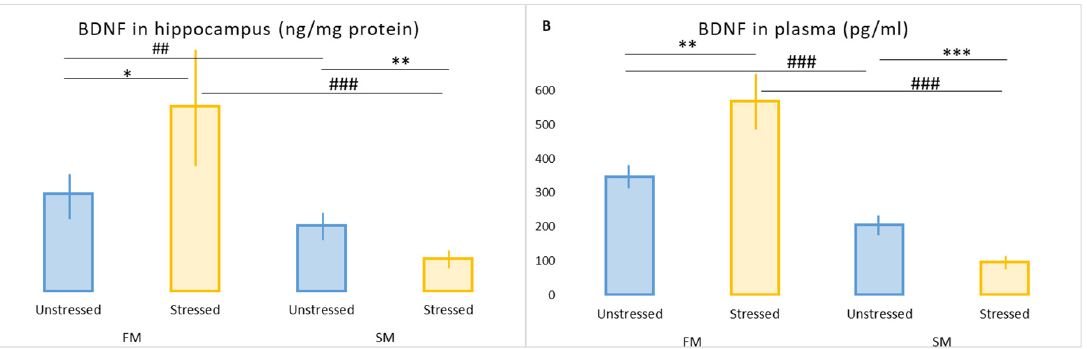
Figure 2. Values are means ± SD. * p < 0.05, ** p < 0.01, *** p < 0.001 vs. respective unstressed rats. ## p < 0.01, ### p < 0.001 vs. respective fast metabolizers. ( A ) BDNF concentration in hippocampus; ( B ) BDNF concentration in plasma. SM, slow metabolizer; FM, fast metabolizer; DAT, dopamine transporter; MAO, monoaminoxidase; COMT, catechol-O-methyltransferase; BDNF, brain-derived neurotrophic factor.